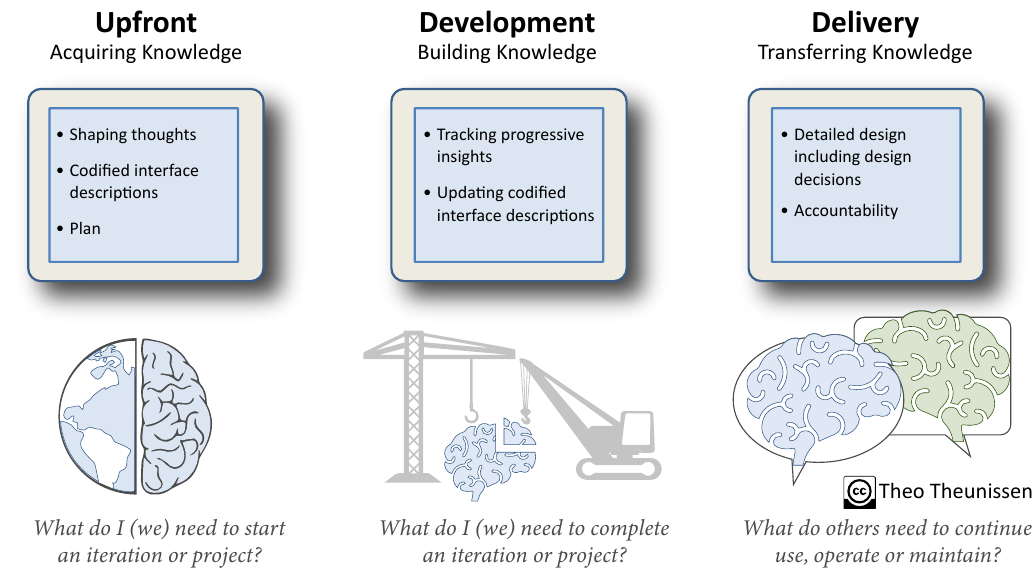
Figure 1. Phases with Knowledge Acquisition, Knowledge Building, and Knowledge